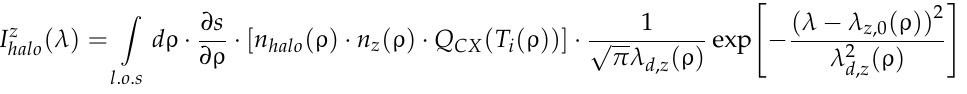
Figure 11. ( a ) radial profile of halo fraction (I halo /(I prompt +I halo ), HeII 9MA-steady-state-at-burn scenario; ( b ) radial profile of halo fraction (I halo /(I prompt +I halo ), HeII 15MA-flat-density scenario. The observed halo spectrum is a line-of-sight-integrated spectrum. Each step along the line-of-